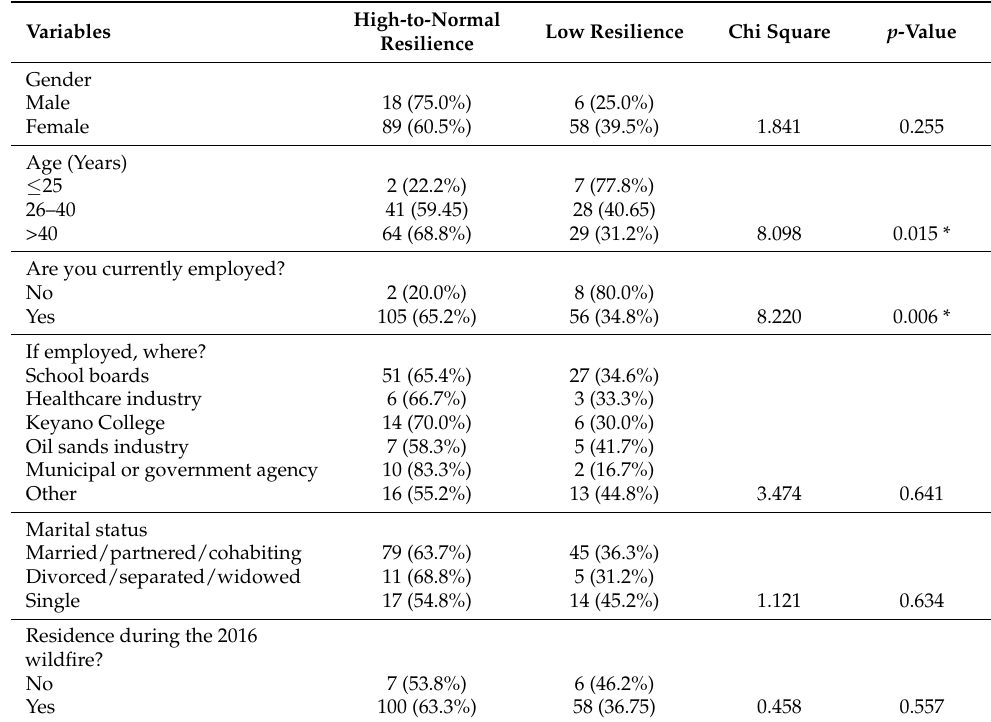
Table 2. Chi-square analyses of relationships between variables * and high-to-normal resilience and low